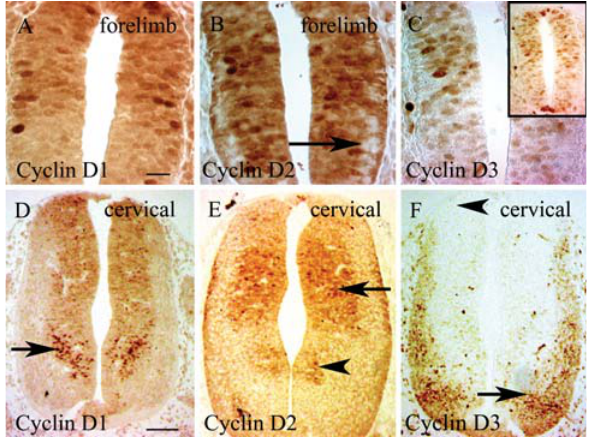
Figure 1 - Consecutive sections through the mouse spinal cord (SC) are shown. Protein expression of D-type cyclins at the E10.5 embryonic stage at the forelimb-level (A-C) and the E12.5 embryonic stage at the cervical level (D-F). (A) Cyclin D1 is expressed in all or most cells but at higher levels in the dorsal SC. (B) Although cyclin D2 shows equal expression levelsinthemajorityoftheSC,theproteinismissinginsomemantlezone cells (arrow). (C) Cyclin D3 is expressed at higher levels in the dorsal spi- nalcordandatthehighestlevelsinthefloorplateandinasmallcell popu- lation of the roof plate. (D) Expression of cyclin D1 in the ventricular and the intermediate zone. Highest protein levels are found ventrally (arrow). (E) Expression of cyclin D2 dorsally in cells of the ventricular and the in- termediate zones (arrow) and at weak levels in a ventral cell population (arrowhead). (F) Expression of cyclin D3 in the mantle zone (arrow) is missing in the dorsal region (arrowhead). Dorsal on the top; Ventral at the bottom.Scalebars:InA,50 μ mforA-C;InD,50 μ mforD-Fandtheinlay of Table 1 - 1. Expression of D-type cyclins in the developing mouse spinal cord. The number of plus symbols indicates the staining intensity (+++ >